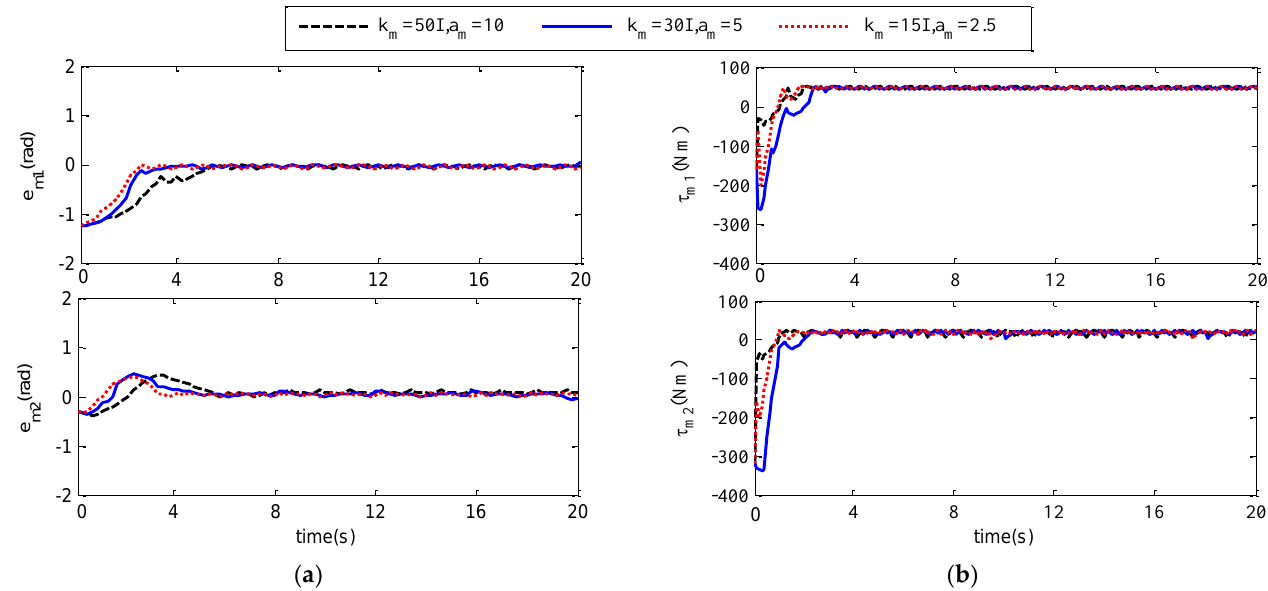
Figure 7. 𝑒 𝑚 and 𝜏 𝑚 under different control parameters. ( a ) The joint position tracking error 𝑒 𝑚 of the main robot; ( b ) Joint input torque 𝜏 𝑚 of master robot